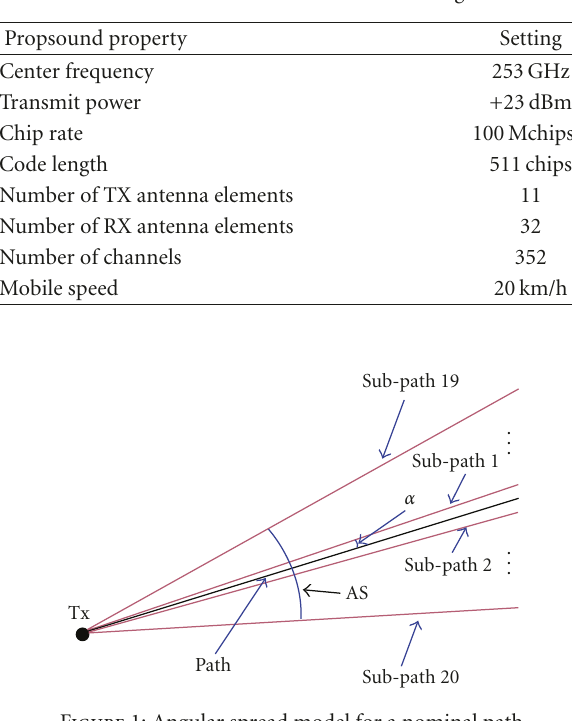
Figure 1: Angular spread model for a nominal path.